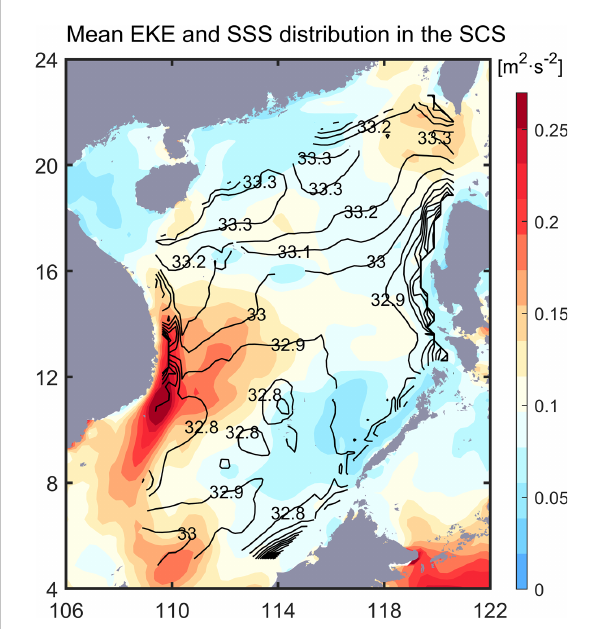
FIGURE 1 Seven-year (2015-2021) averaged EKE (shading, unit: m 2 ·s -2 ) and SSS (black contours, unit: psu) distributions in the